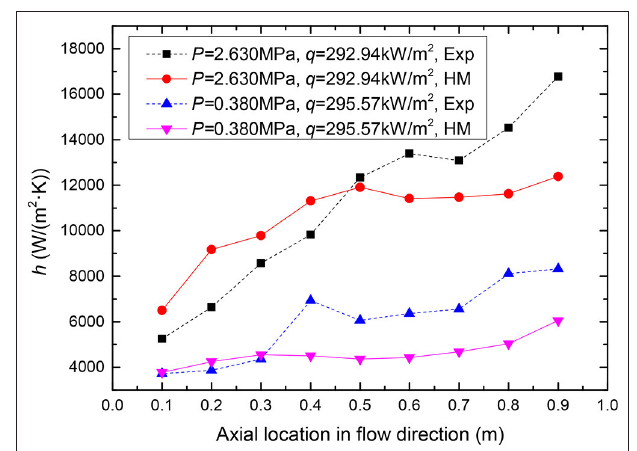
FIGURE 10 | The comparisons between experimental and numerical heat transfer coefficients for q = 349.36 kW/m 2 and G = 500 kg/(m 2 · s).